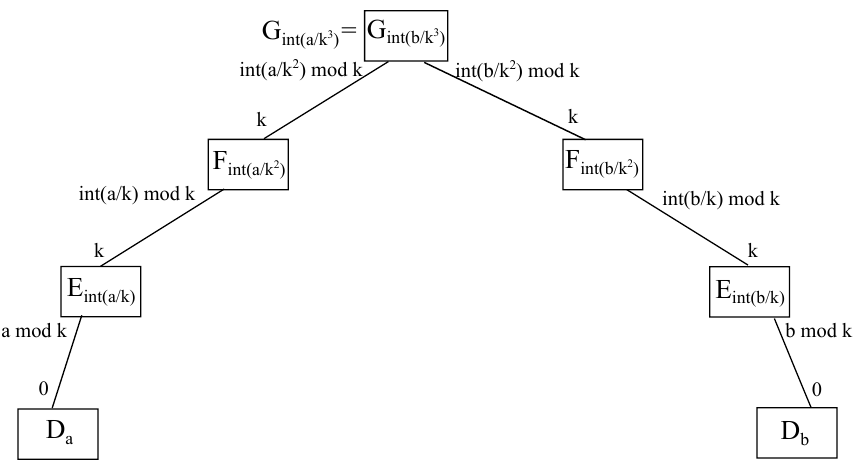
Figure 11. Schematic diagram for hub and spoke interfog communication.